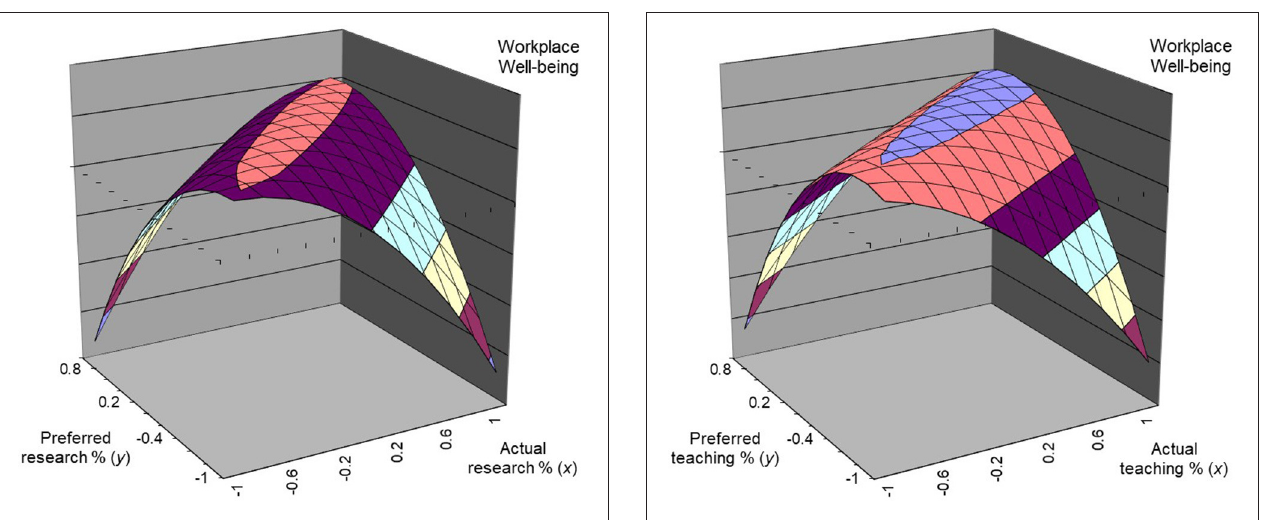
the underlying mechanism later, as stressed by Sonnentag et